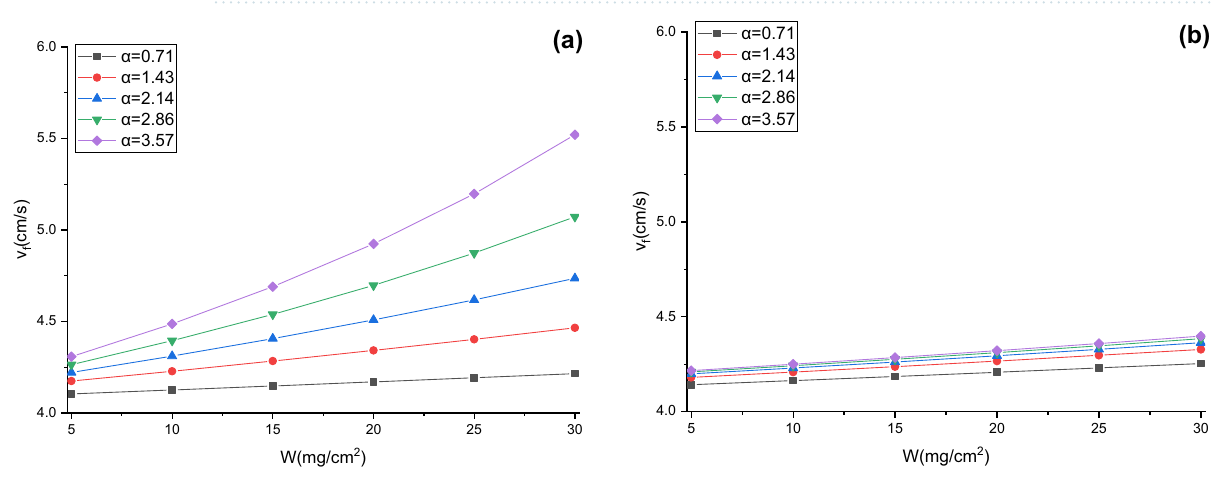
Figure 12. Dust cake thicknesses obtained by the model ( a ) V-shaped, ( b ) U-shaped.